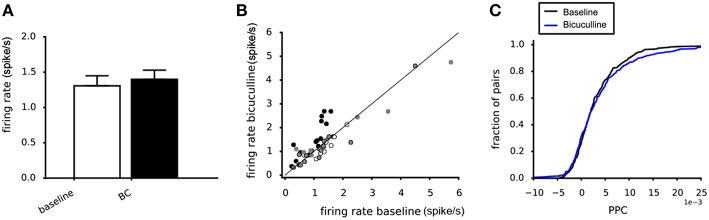
Effect of Bicuculline on the dopamine neuron population activity and connectivity. (A) The mean firing rate was not affected by 20 μM Bicuculline, when averaging across four experiments (white vs. black bar). (B) Relation between the mean firing rate during 20 μM Bicuculline and the mean firing rate at baseline for four experiments (filled and non-filled dots). A systematic response to Bicuculline was not found. (C) The cumulative PPC histograms for the baseline and 20 μM bicuculline conditions. The two distributions were not different, indicating that bicuculline had no effect on the network strength when averaged over four experiments (baseline: 305 pairs, bicuculline: 305 pairs).